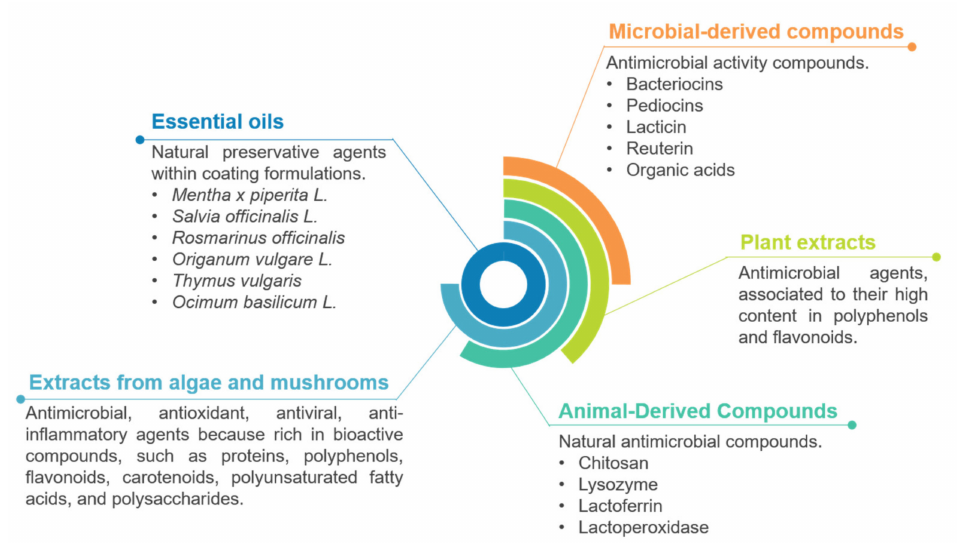
Figure 2. Natural compounds frequently used in edible active coatings. Table 8. Recent advances in the antioxidant and antimicrobial properties of films reinforced with nanocellulose (literature data for years